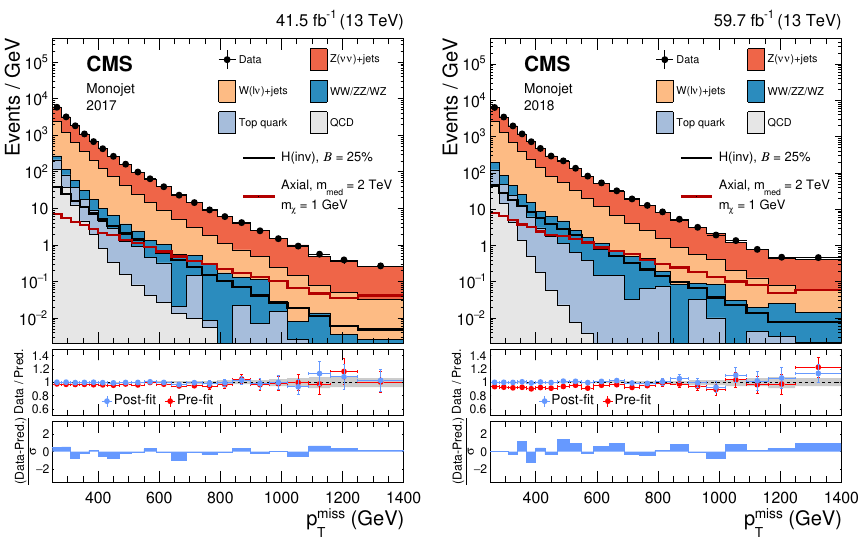
Figure 4 . Comparison between data and the background prediction in the monojet signal region before and after the simultaneous fit. The fit includes all control regions and the signal region in all categories and both data taking years, and the background-only fit model is used. The resulting distributions are shown separately for 2017 (left) and 2018 (right). Templates for two signal hypotheses are shown overlaid as black and dark red solid lines. The last bin includes the overflow. In the middle panels, ratios of data to the pre-fit background prediction (red solid points) and post-fit background prediction (blue solid points) are shown. The gray band in the middle panels indicates the post-fit uncertainty after combining all the systematic uncertainties. Finally, the distribution of the pulls, defined as the difference between data and the post-fit background prediction divided by the quadratic sum of the post-fit uncertainty in the prediction and statistical uncertainty in data, is shown in the lower